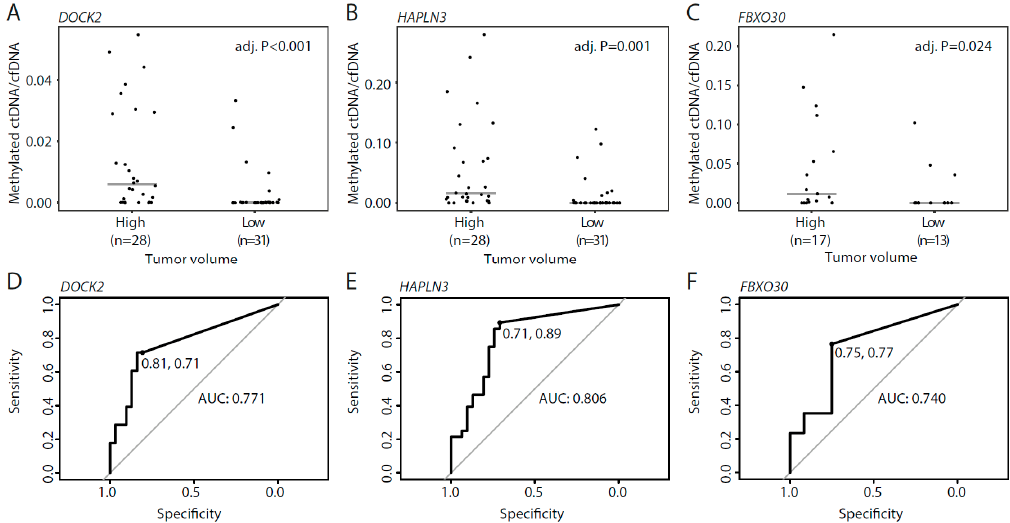
Figure 5. Methylated ctDNA in de novo mPCa patients with high and low tumor volume. ( A – C ) Ratio between methylated ctDNA and cfDNA for DOCK2 ( A ), HAPLN3 ( B ), and FBXO30 ( C ) in high and low tumor volume. Each dot represents one analyzed sample. ( D – F ) ROC curves comparing high and low tumor volume for DOCK2 ( D ), HAPLN3 ( E ), and FBXO30 ( F ). Horizontal bars indicate median values in each group. p -values were calculated using Mann–Whitney tests. Adj. P, Benjamini–Hochberg adjusted p -value. ROC, receiver operating curve. AUC, area under the